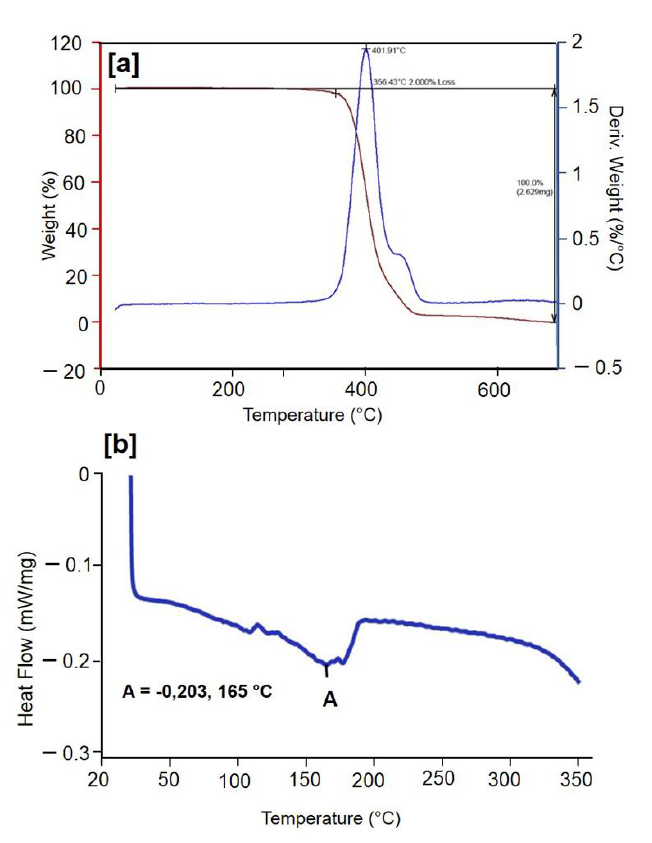
Figure 4. ( a ) TGA curve of TPU filament; ( b ) the DSC curve of TPU filament.